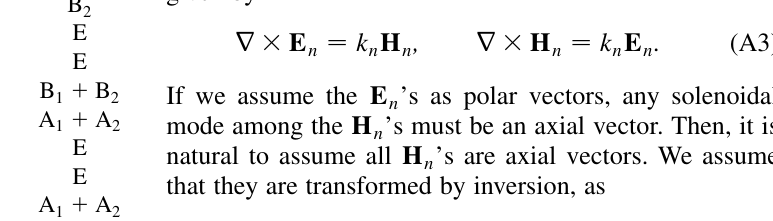
TABLE XIII. Compatibility relations between the irreducible representations of D 1